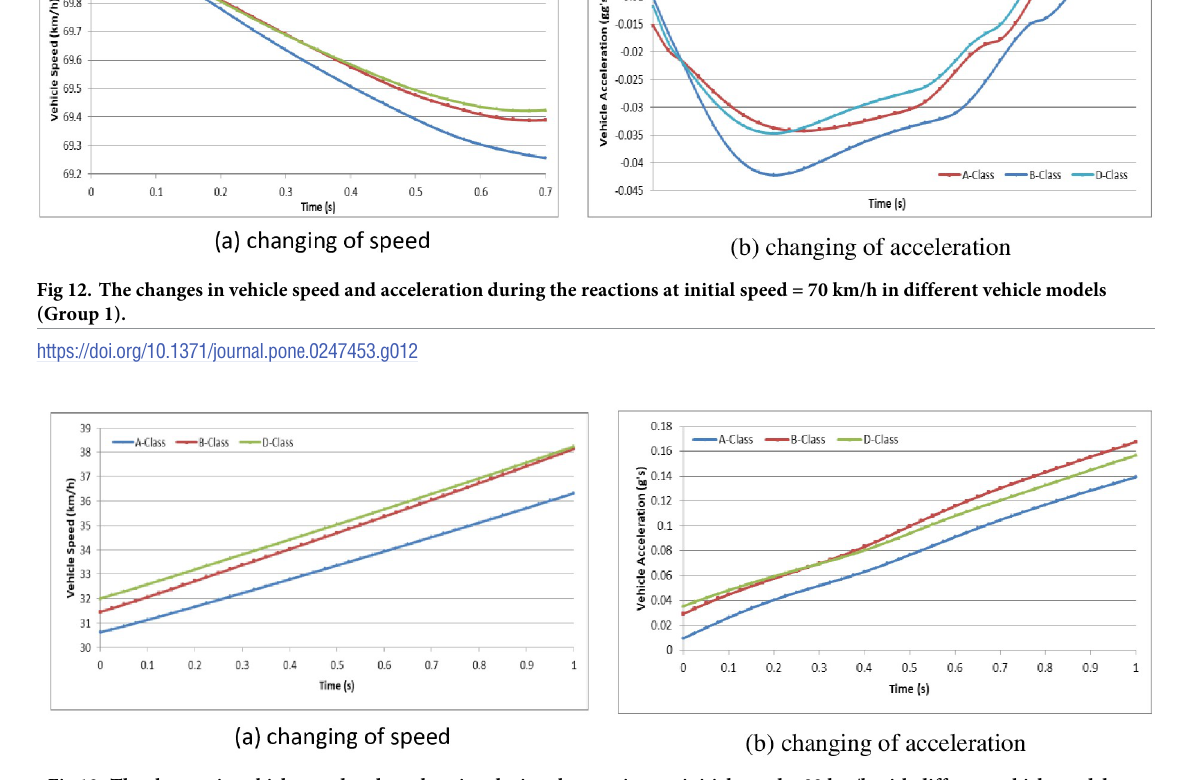
For group 2, it shows out that the driver stepped on the gas pedal gradually but with differ- ent strength. The lower initial speed of vehicle, the driver will step on the gas pedal deeper. The lower initial speed of vehicle, the driver need more time to accelerate the vehicle to go through the signalized intersection. And the driver will step on the gas pedal deeper to obtain more